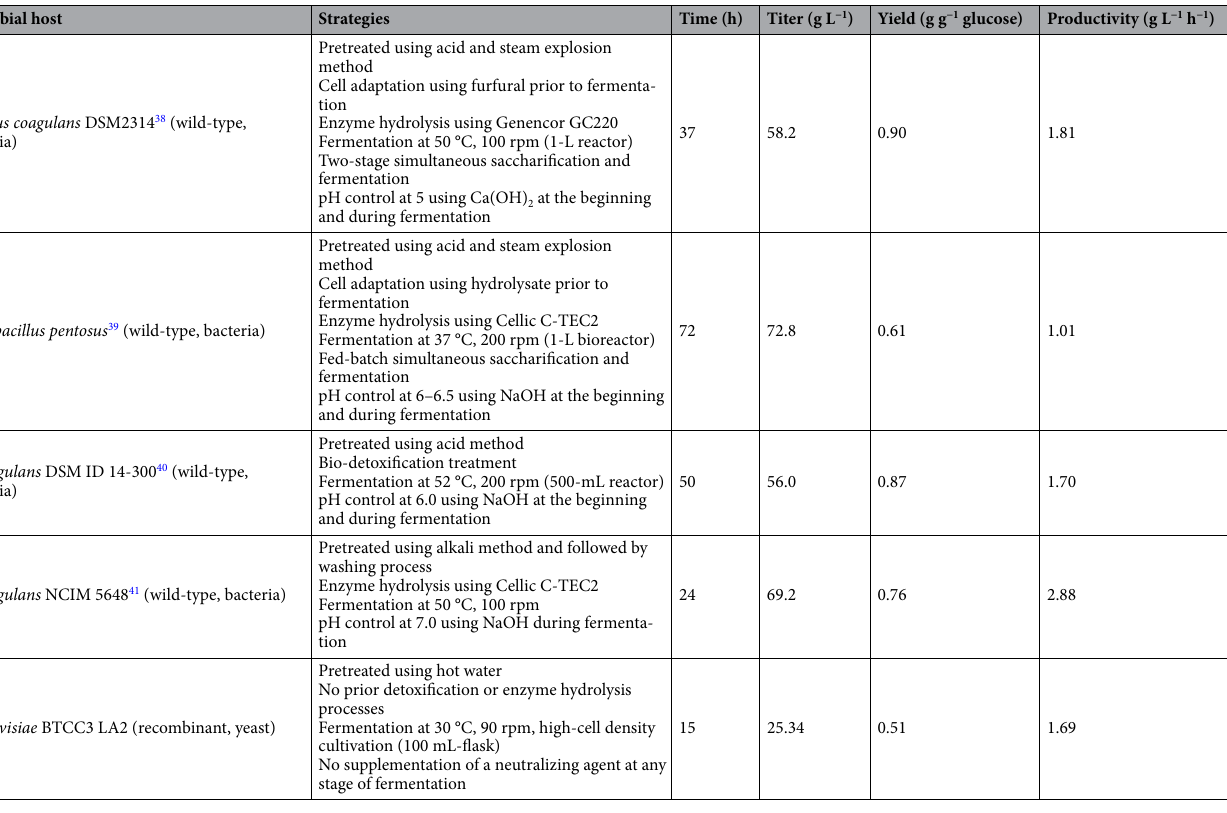
Table 3. Comparison of lactic acid fermentation using sugarcane bagasse as raw material from several